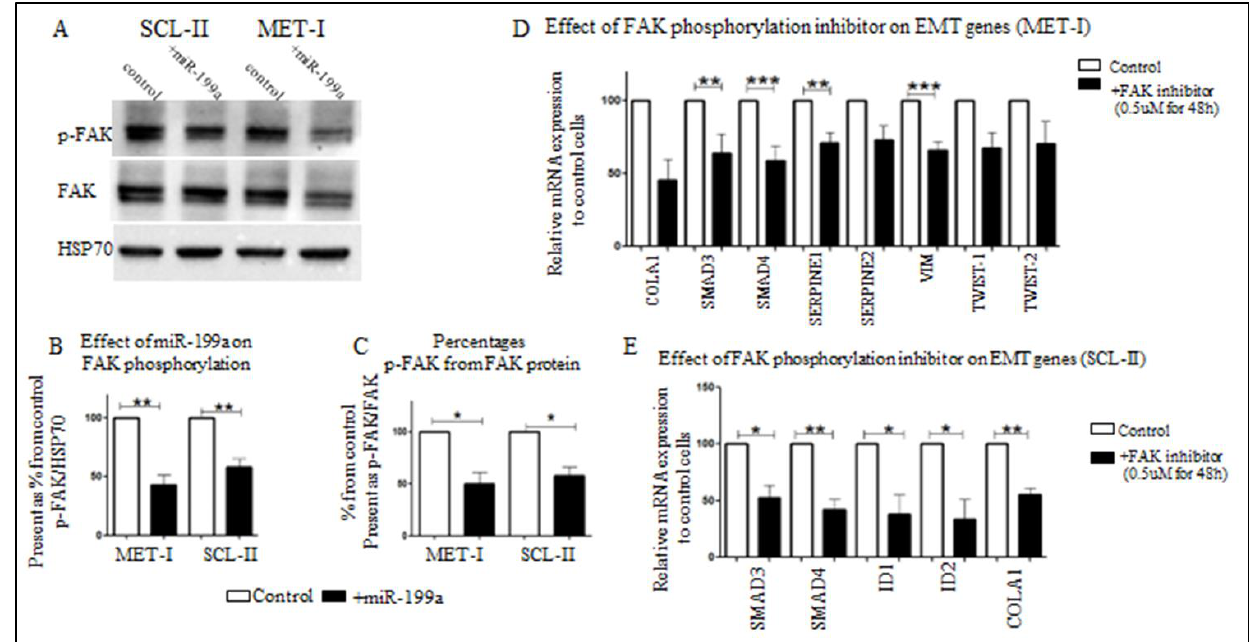
Figure 5. Effect of miR-199a-3p on phosphorylation of FAK and effect of inhibition of FAK-phosphorylation on EMT genes expression in SCC cells. ( A ) WB analysis of protein extracts from SCL-II and MET1 control cells or cells overexpressing miR-199a-3p, as indicated. The extracted proteins were blotted with the indicated antibodies; phosphorylated FAK (p-FAK), total FAK (FAK), and HSP70. p-FAK densitometry is quantified relative to HSP70 ( B ) and total FAK ( C ) in 3